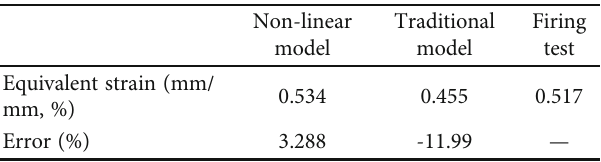
Table 7: Comparison of strain results by the simulation and fi ring